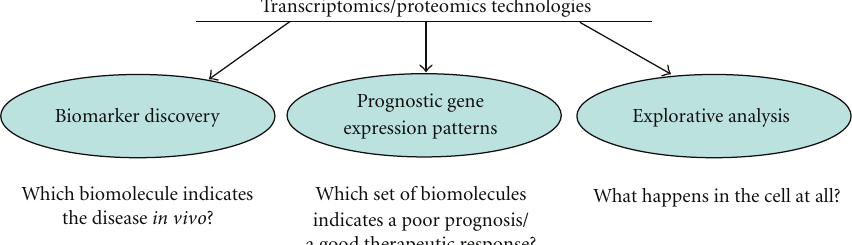
Figure 4: The three main fields for the application of transcriptomics and proteomics technologies and the basic questions behind these